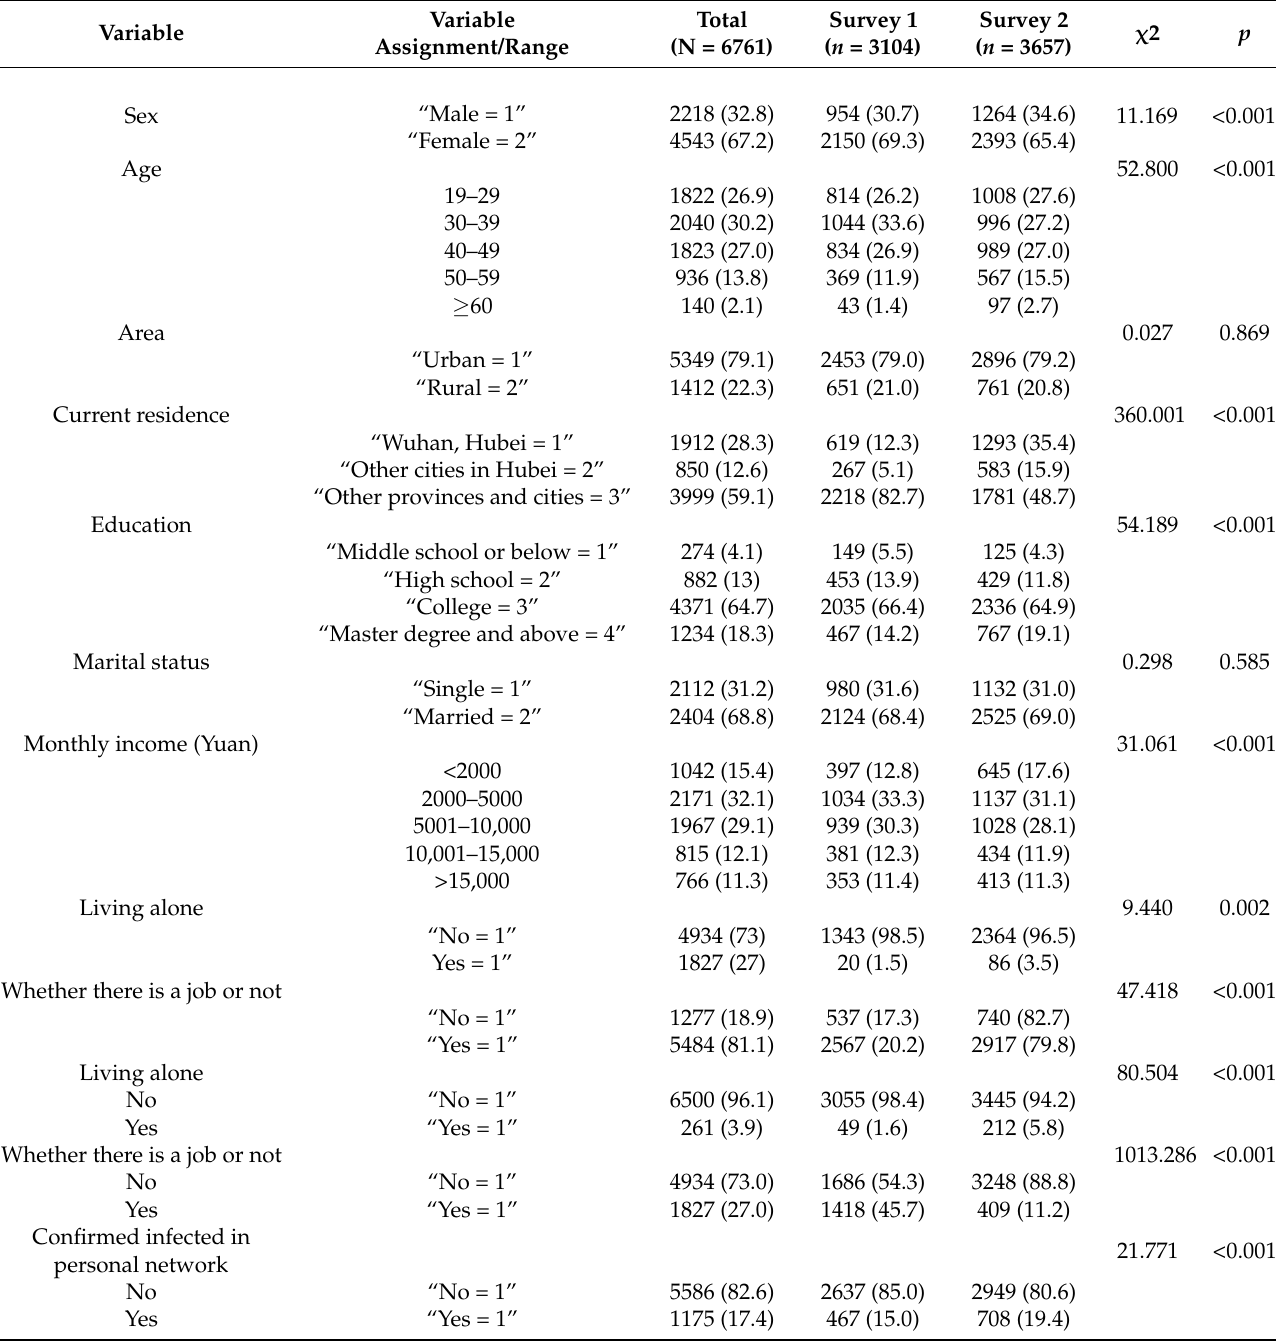
Table 1. Sociodemographic characteristics of participants in the two